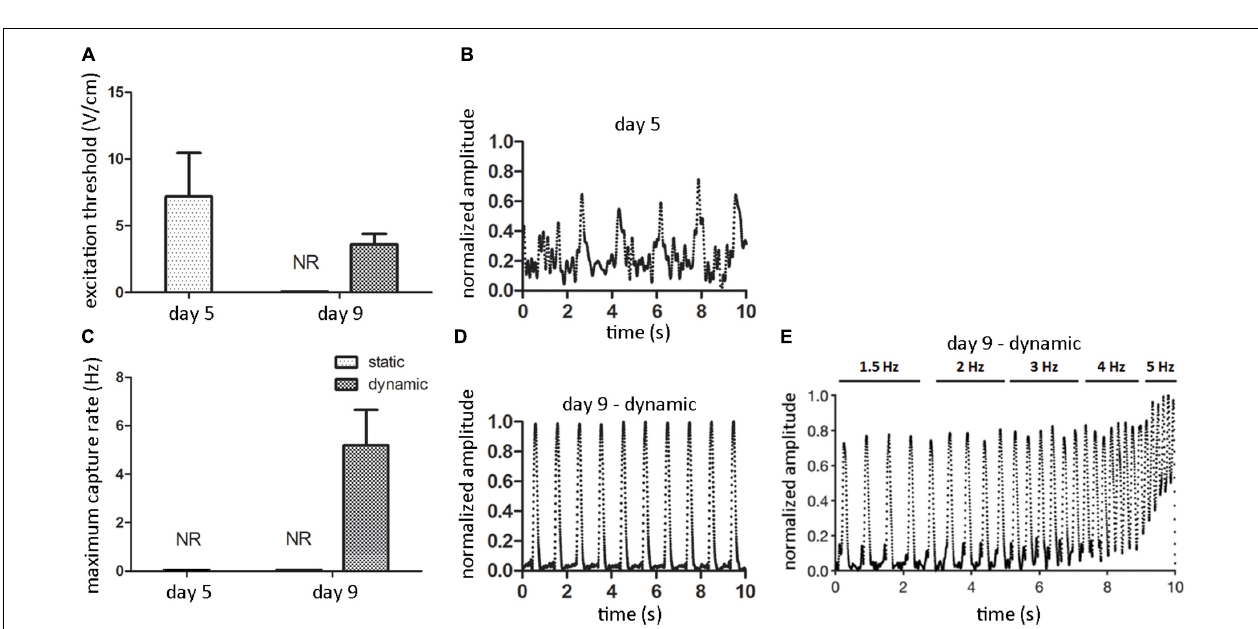
FIGURE 6 | ECT mechanical characterization. Linear elastic modulus (E) values (A) and ultimate tensile strength (UTS) values (B) of freshly casted ECTs (day 1), ECTs at day 5, and statically and dynamically cultured ECTs at day 9 collected immediately after in situ force monitoring and measured using a standard testing machine. For all groups, n ≥ 3, ∗ p ≤ 0.05; ∗∗ p ≤ 0.01; ∗∗∗ p ≤ 0.001; ∗∗∗∗ p ≤ 0.0001.